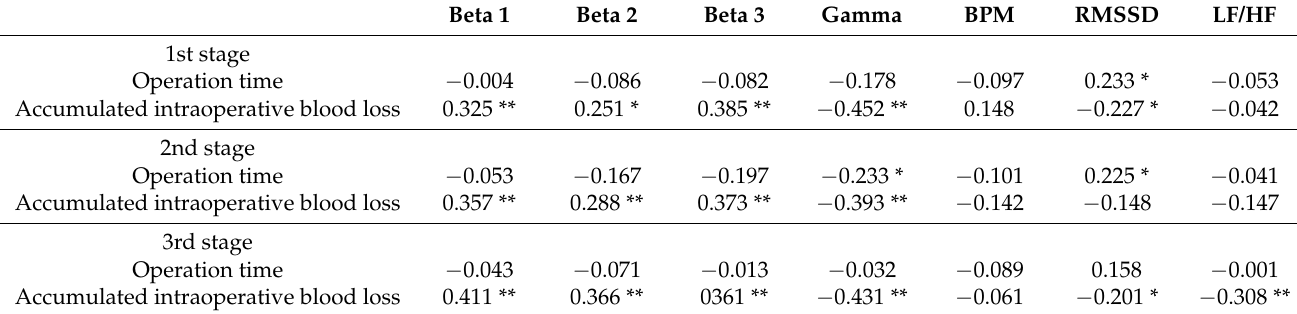
Table 3. Correlation Analysis Between the Stress-Related Parameters of the Surgeon in Non-Tourniquet Applied Orthopedic Surgery. * p < 0.05, ** p < 0.01 Beta 1: low beta waves, 12–15 Hz; Beta 2: mid-range beta waves, 15–20 Hz; Beta 3: high beta waves, 20–30 Hz; Gamma; 30–50 Hz; BPM: beats per minute, RMSSD: square root of the mean R-R interval; LF: low frequency, HF: high frequency.